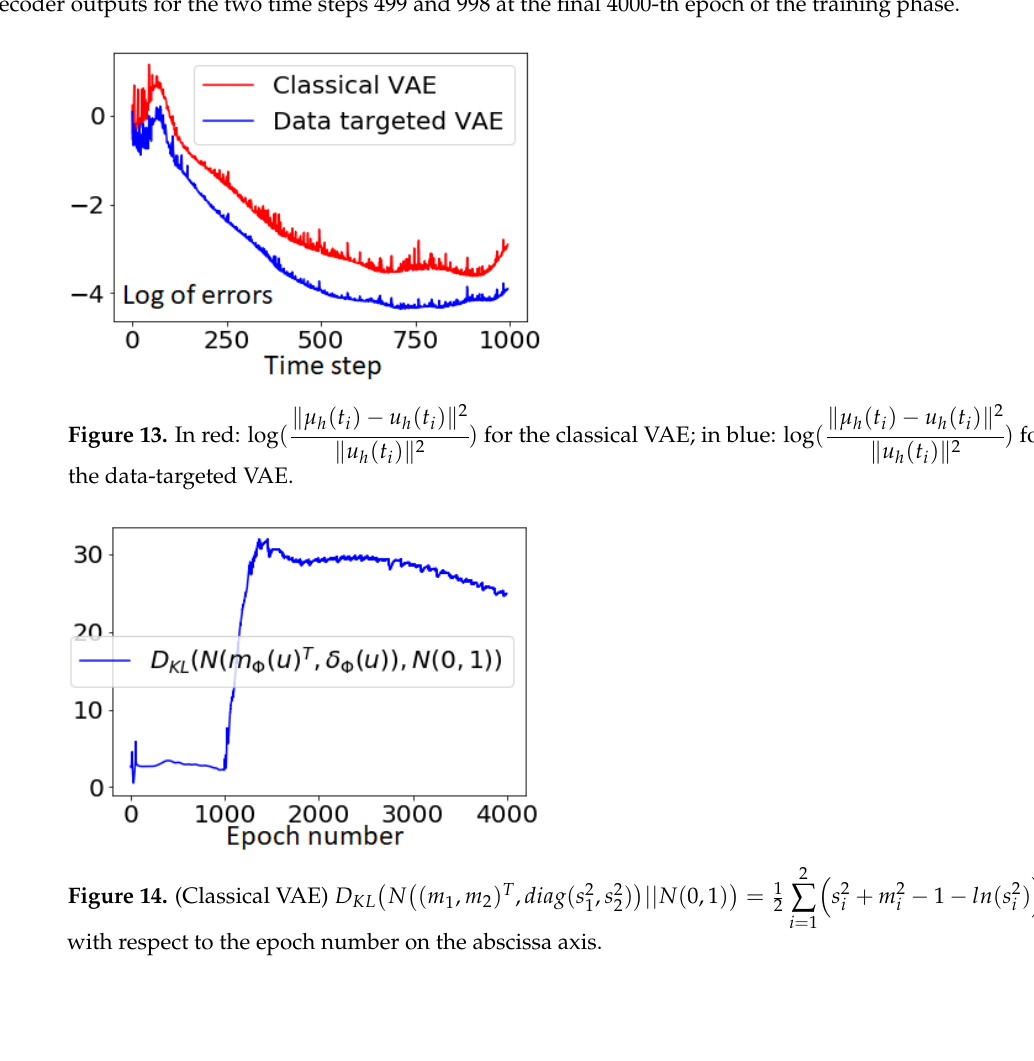
) (cid:1) || N ( 0,1 ) (cid:1) = 1 , s 2 2 1